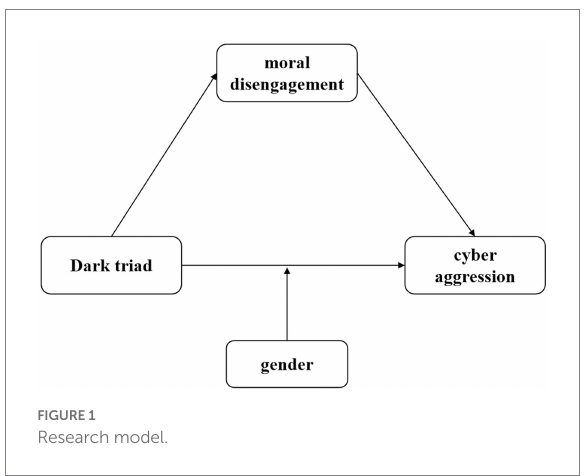
FIGURE 1 Research